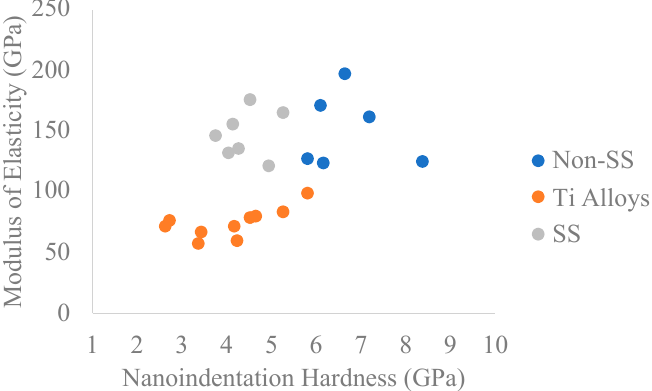
Figure 37. Figure 37. Modulus of elasticity versus hardness of the three categories of steel and Ti-based gas- atomized powders.